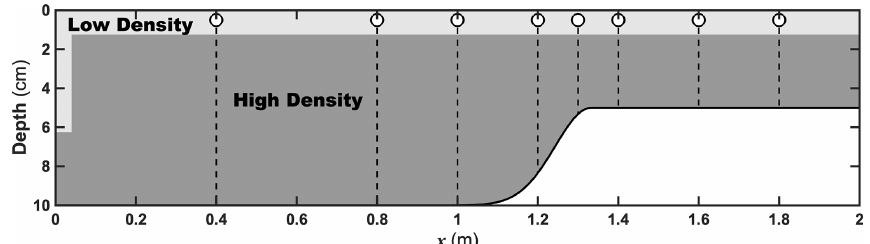
Figure 8. As in Fig. 4, but with half-Gaussian topography in the east of the tank; eight white dots refer to the high-frequency output points.